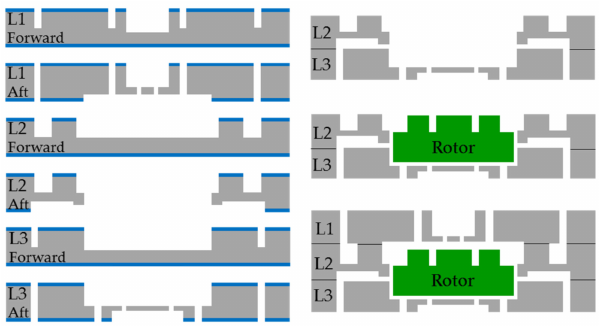
Figure 3. Key microfabrication process flow for micro air bearings